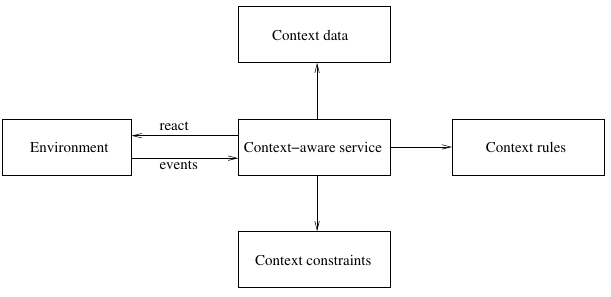
Figure 2. A simple context-aware